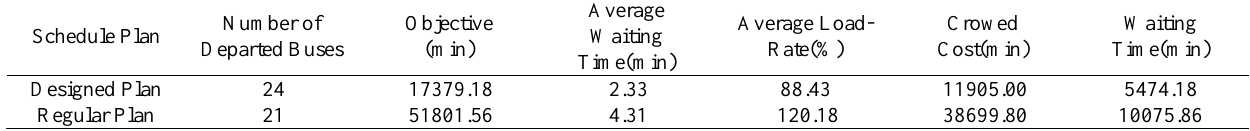
Table 5. The comparison between two transit scheduling